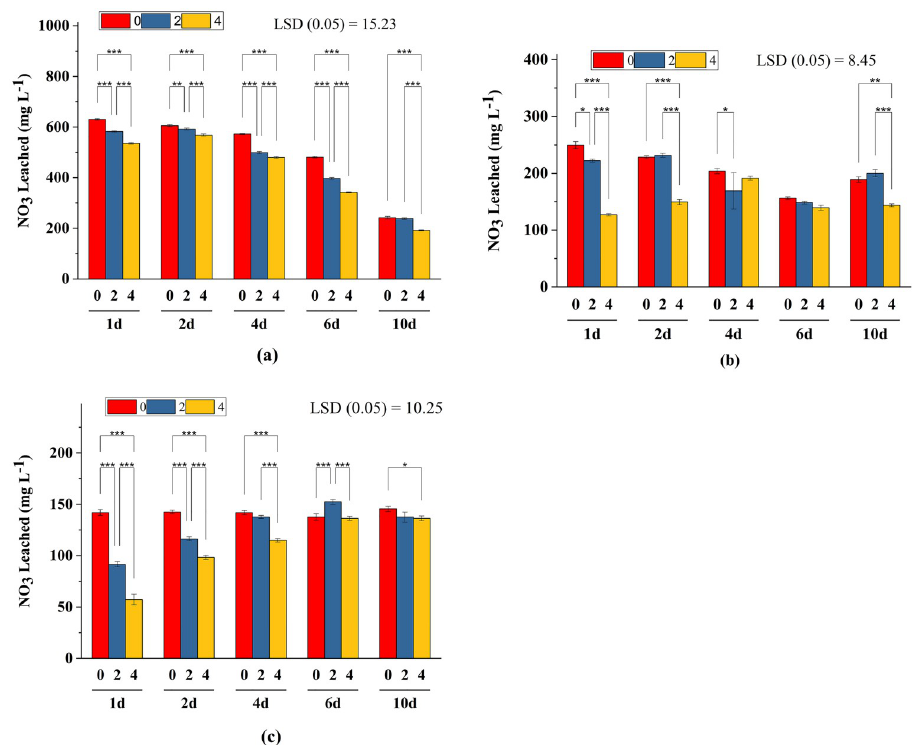
Fig 3. Nitrate leaching in bentonite amended sandy soil using Ca(NO 3 ) 2 (a), NH 4 Cl (b), and CO(NH 2 ) 2 (c) with 0%, 2% and 4% bentonite during five leaching events (days). � , �� and ��� show significant difference at P < 0.05, P < 0,01 and P < 0.001,